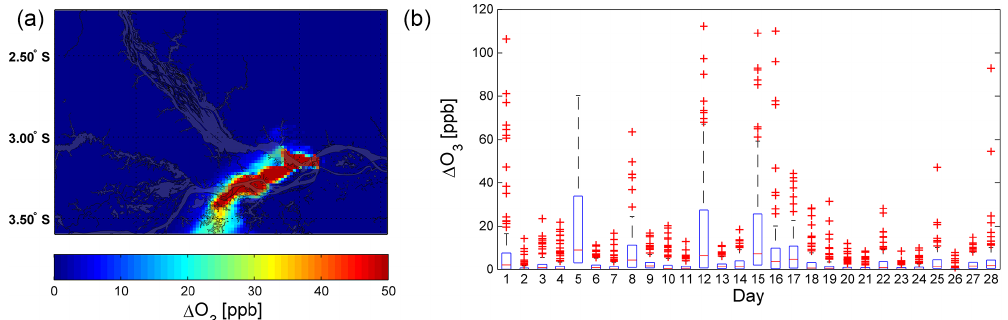
Figure 4. Difference analysis for historical compared to planned future emissions (i.e., case A minus case C). (a) Difference map of ozone concentrations (cf. Fig. 3). (b) Box-and-whisker plot of differences in afternoon ozone concentrations during the 1-month time series (cf. Fig.